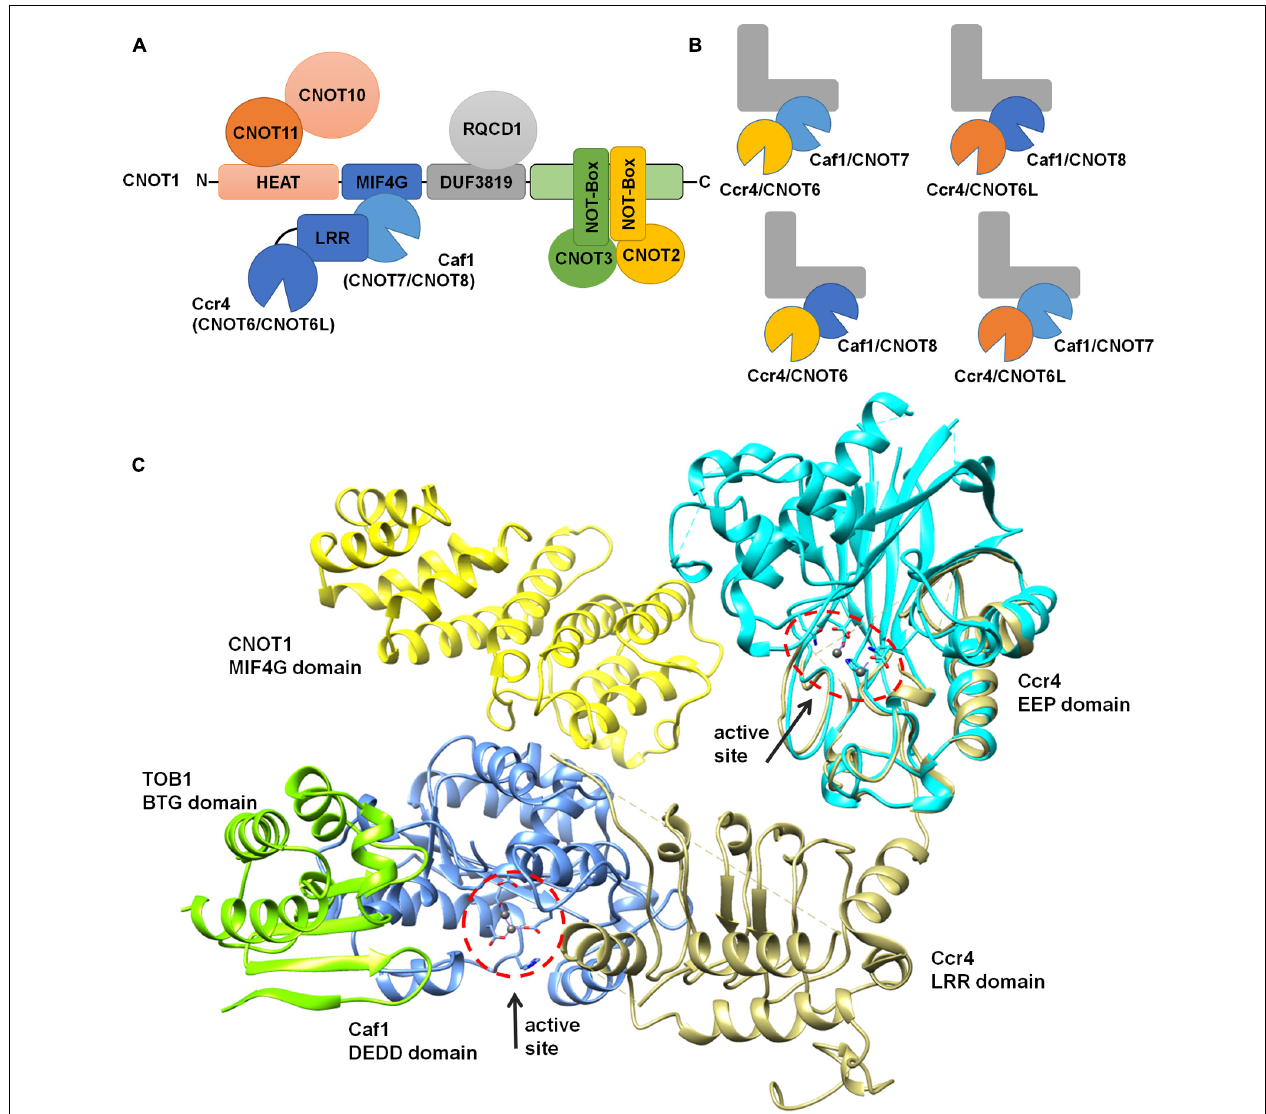
domain of human Ccr4/CNOT6L (cyan).The location and orientation of the active sites of Caf1 and Ccr4 are indicated and Mg(II) ions are shown (dark gray).The model was generated by superimposing theTob-Caf1 structure (PDB accession number 2D5R), the MIF4G domain of human CNOT1 in complex with Caf1/CNOT7 (PDB accession number 4GMJ), and the EEP nuclease domain of human Ccr4/CNOT6L (PDB accession number 3NGO) on the structure of the yeast Not1-Caf1-Ccr4 complex (PDB accession number 4B8C). Molecular graphics and analyses were performed with the UCSF Chimera package (http://www.cgl.ucsf.edu/chimera; Pettersen etal.,